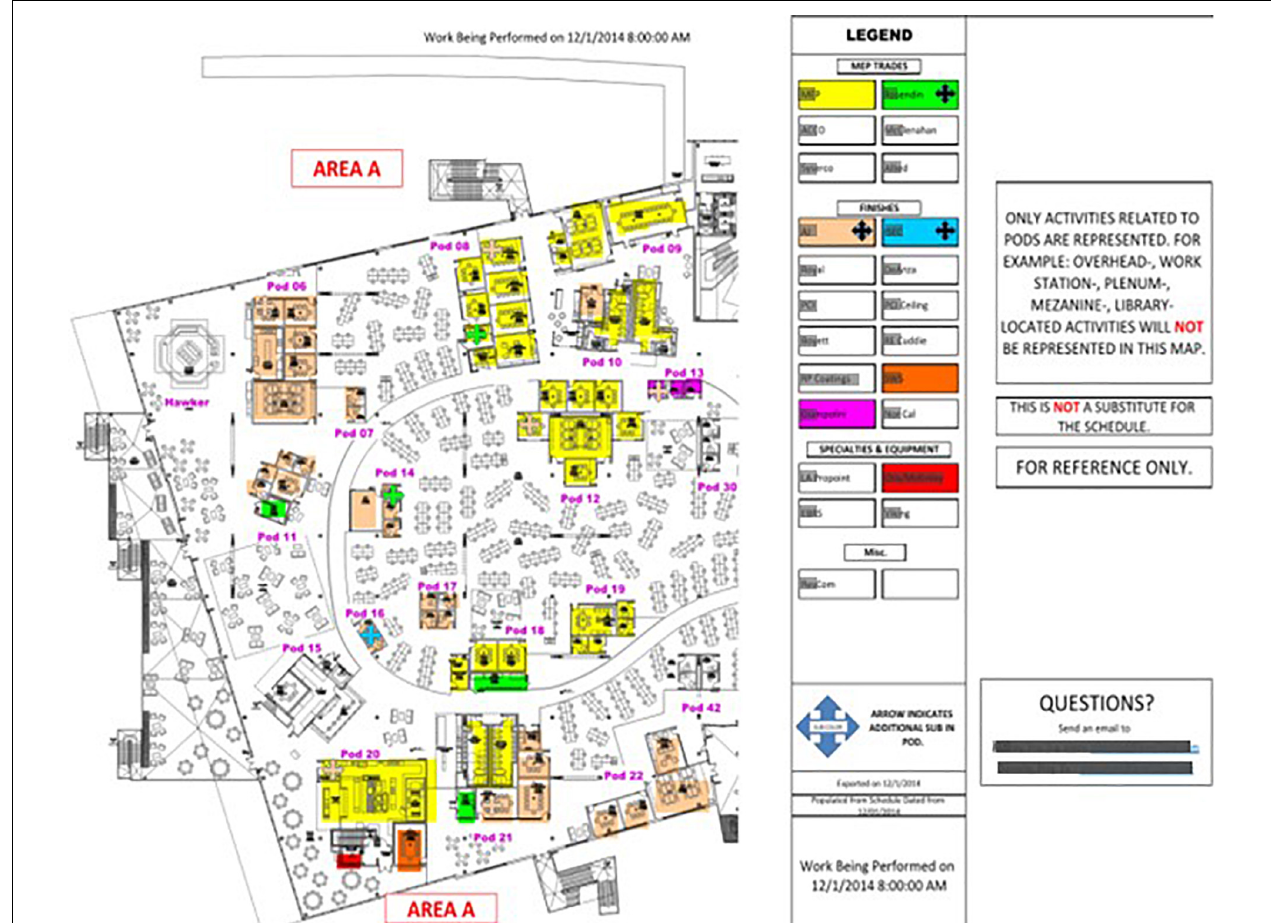
FIGURE 6 | Output of LoSite for Area